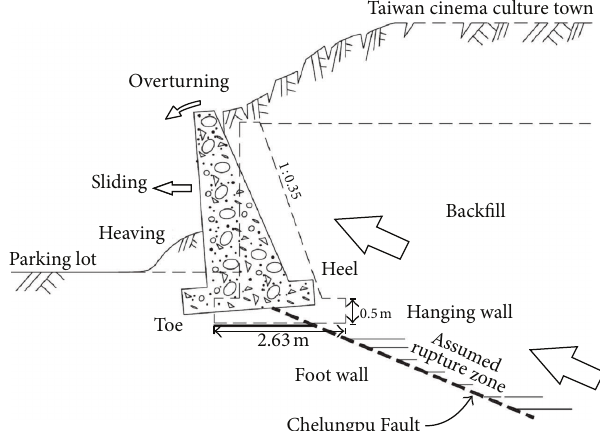
Figure 6: Geometry and failure mechanism of a retaining wall in Chi-Chi Earthquake, Taiwan (after